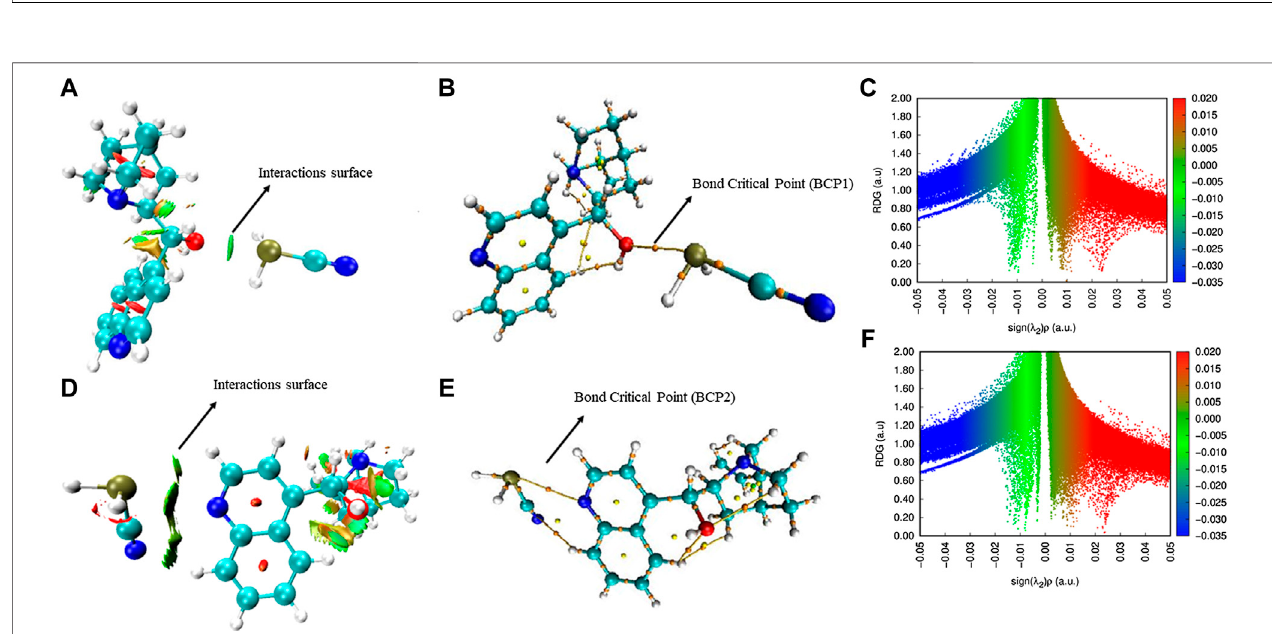
FIGURE 7 | Proposed models of the cinchona alkaloid – catalyzed asymmetric reaction.